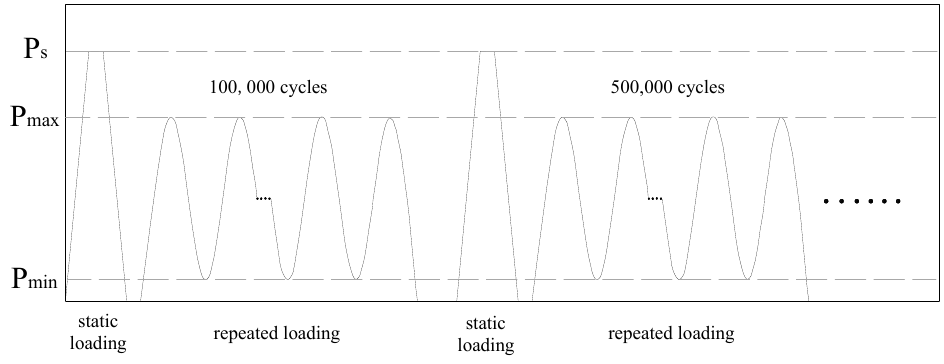
Figure 8. Procedure of the test.